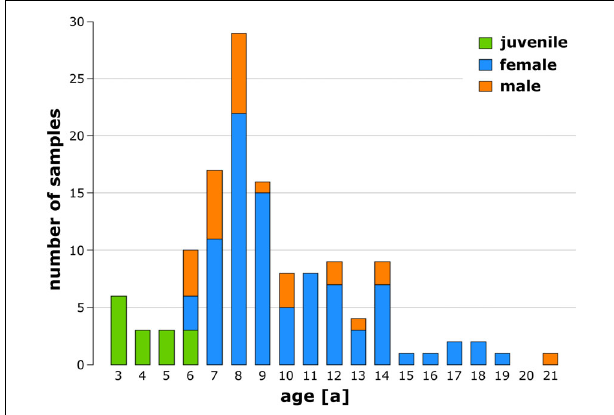
FIGURE 3 | Number of analyzed juvenile (green), female (blue), and male (orange) European mistletoe plants sorted by age.